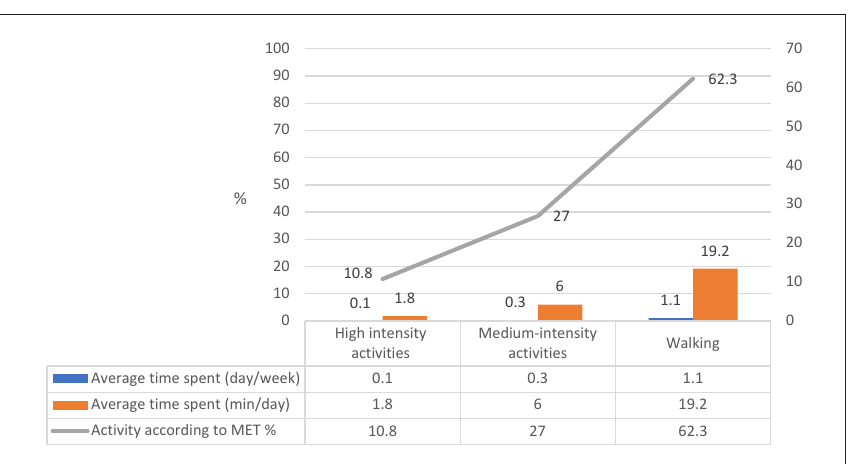
Figure 1. Distribution of respondents according to the average physical activity intensity indicators in the low FA level group